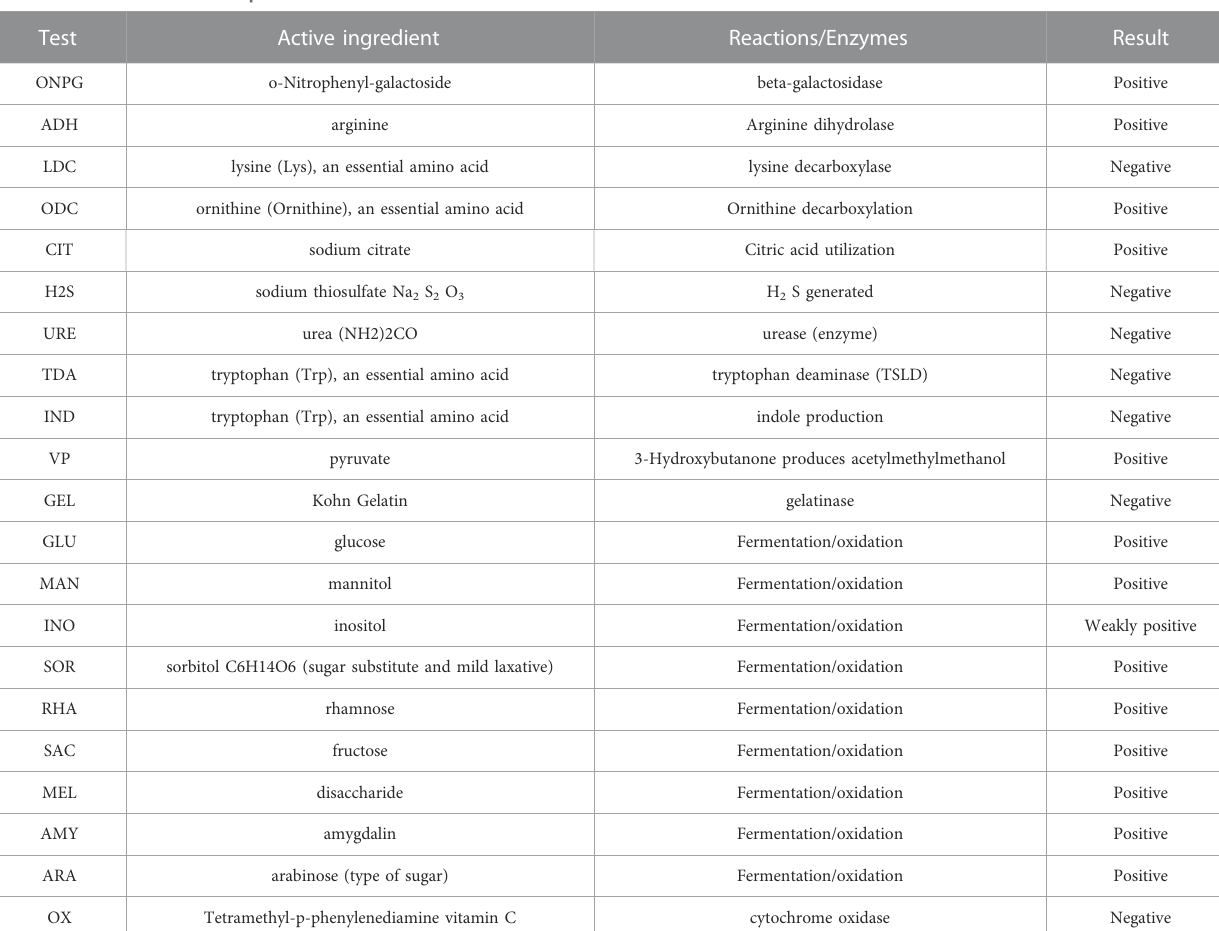
TABLE 6 API test results of Group B characteristic